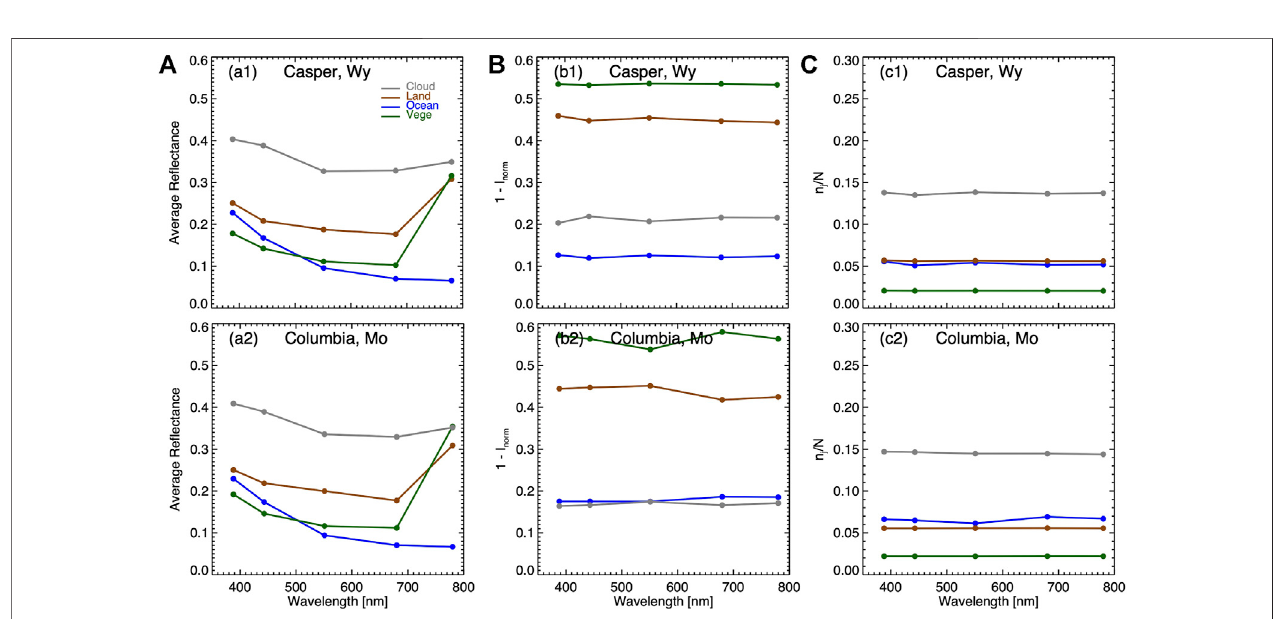
FIGURE 10 | Similar to Figure 8 but for the two cases during the 2017 solar eclipse.